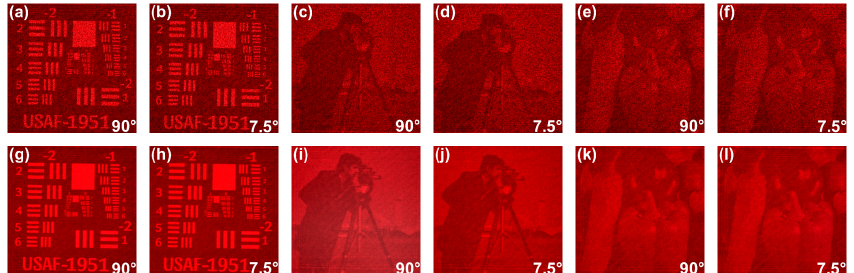
Figure 11. Optical reconstructed results of the proposed PC method. ( a – f ) and ( g – l ) are results without and with optimization,